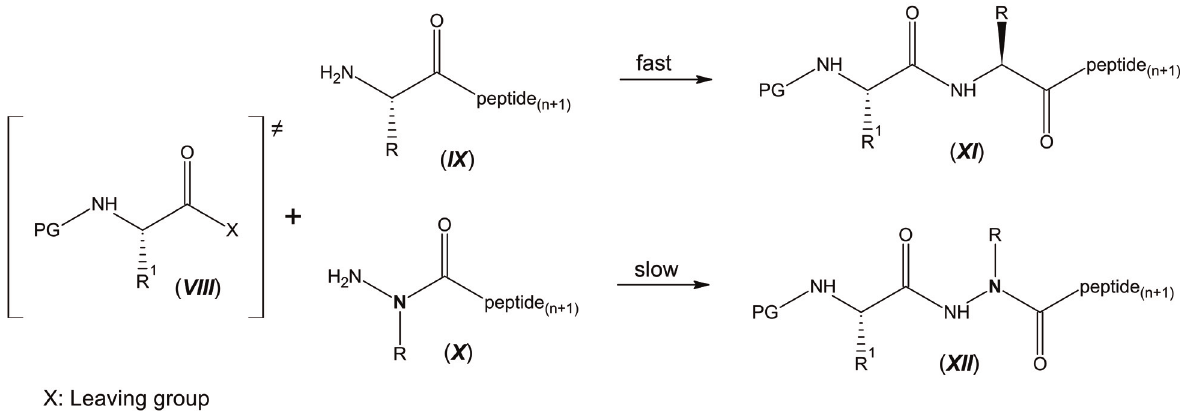
Scheme 4. Comparison of peptide and aza-peptide bond